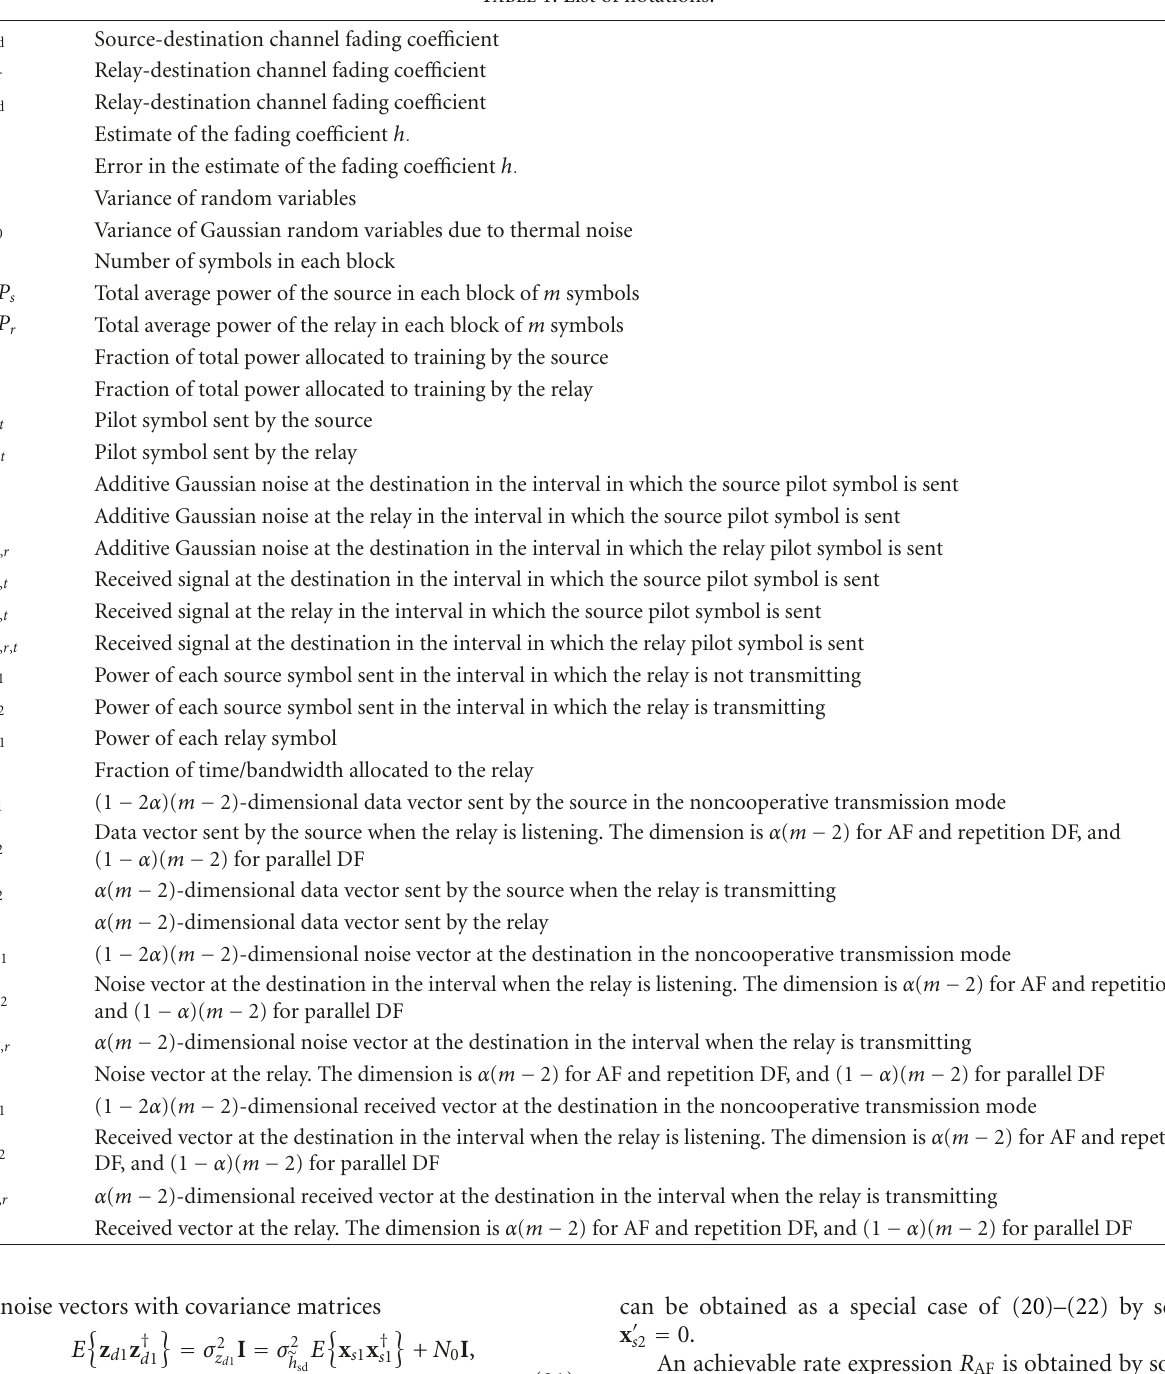
Table 1: List of